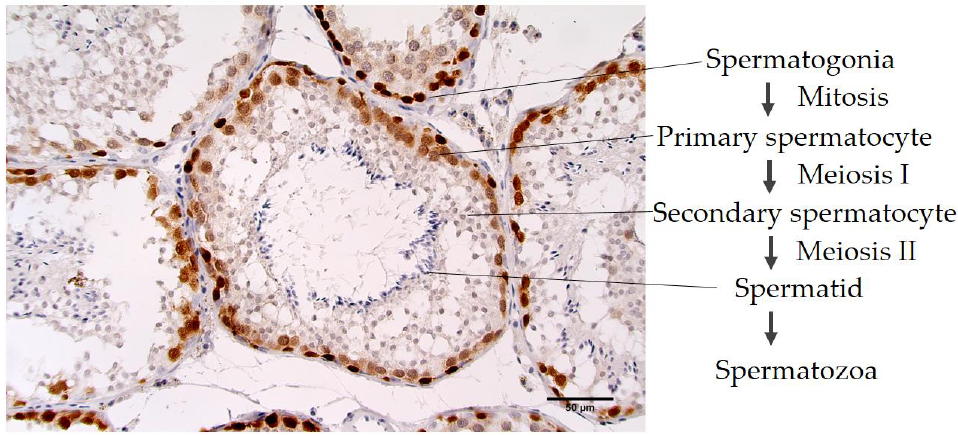
Figure 2 . Positive cross - reactivity of MAb 6C1, testis and canines . The location of MAGE expression in Figure 2. Positive cross-reactivity of MAb 6C1, testis and canines. The location of MAGE expression in canine testicular tissue sections ( 40× ). canine testicular tissue sections (40 ×